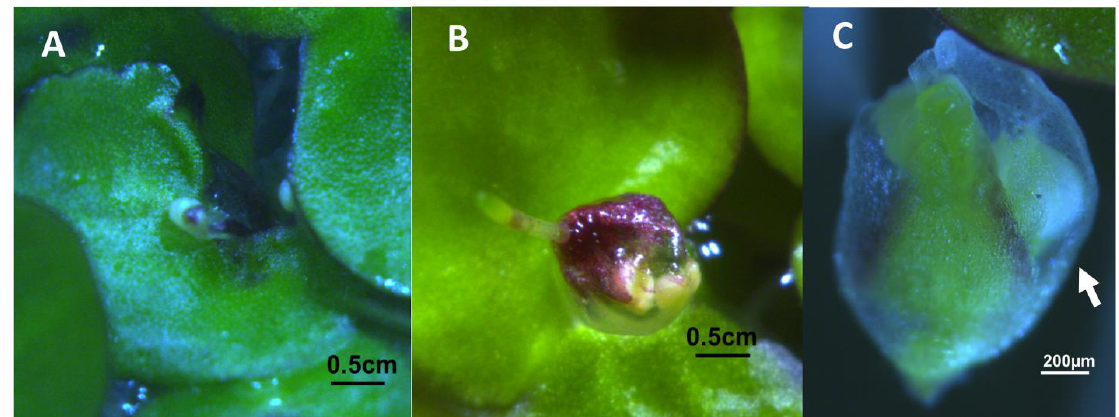
Figure 3. Anomalous flowers of S, polyrhiza. ( A ) An abnormal flower of strain 7498 that appears to have emerged from an abnormal, kidney shaped frond. ( B ) This inflorescence on strain 9509 appeared to be overgrown by the underside of the frond. The purple pigmentation is similar to that of the ventral surface of this strain. The vertical structure appears rhizoid-like. ( C ) An aborted inflorescence of strain 9509, consisting of the developing pistil and anthers enveloped in a spathe, found floating in the medium.